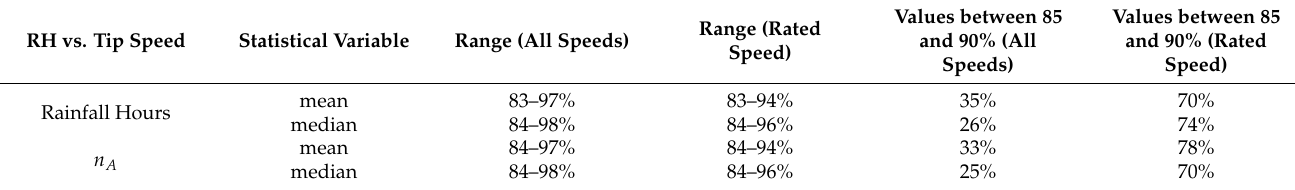
Table 3. Mean and median RH distributions for rainfall hours and n A across all 23